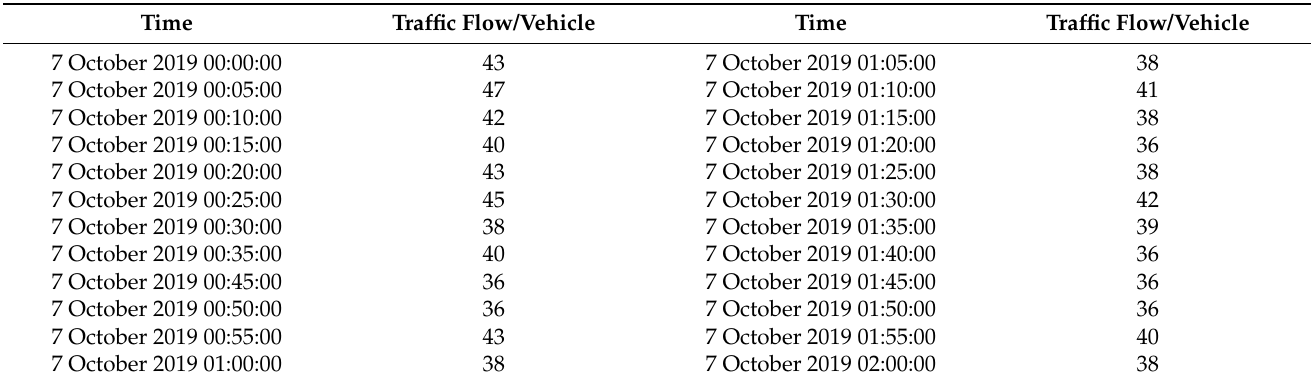
Table 1. Partial traffic flow